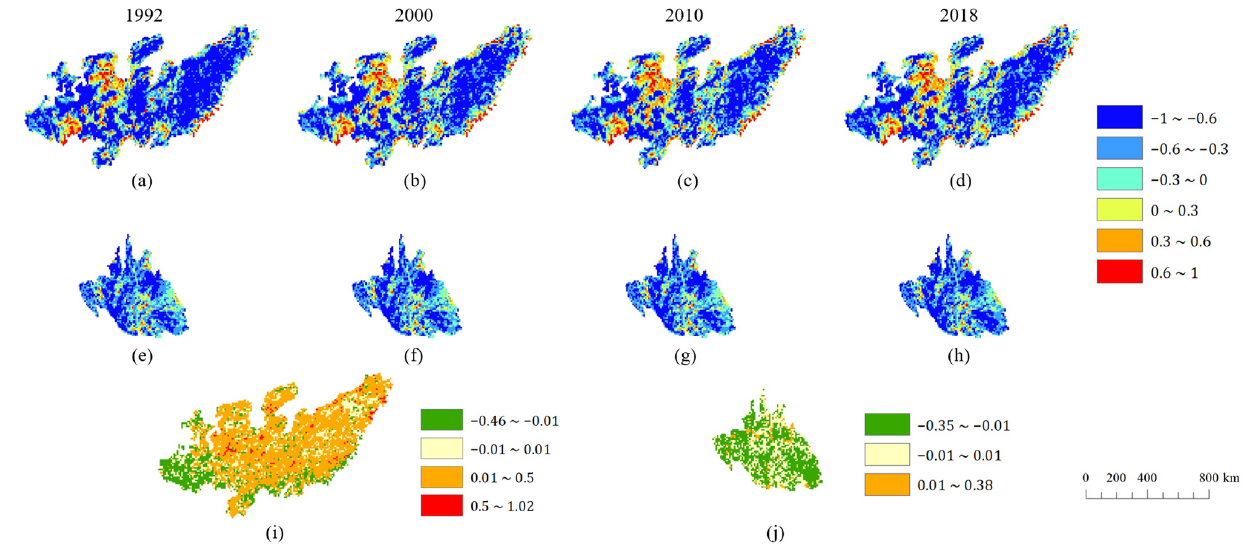
Figure 5. Comparison of the LSS of two typical ecoregions. ( a – d ) Jiang Nan subtropical evergreen forests in 1992, 2000, 2010, and 2018. ( e – h ) Yunnan Plateau subtropical evergreen forests in 1992, 2000, 2010, and 2018. ( i ) Difference between 2018 and 1992 for Jiang Nan subtropical evergreen forests. ( j ) Difference between 2018 and 1992 for Yunnan subtropical evergreen forests.